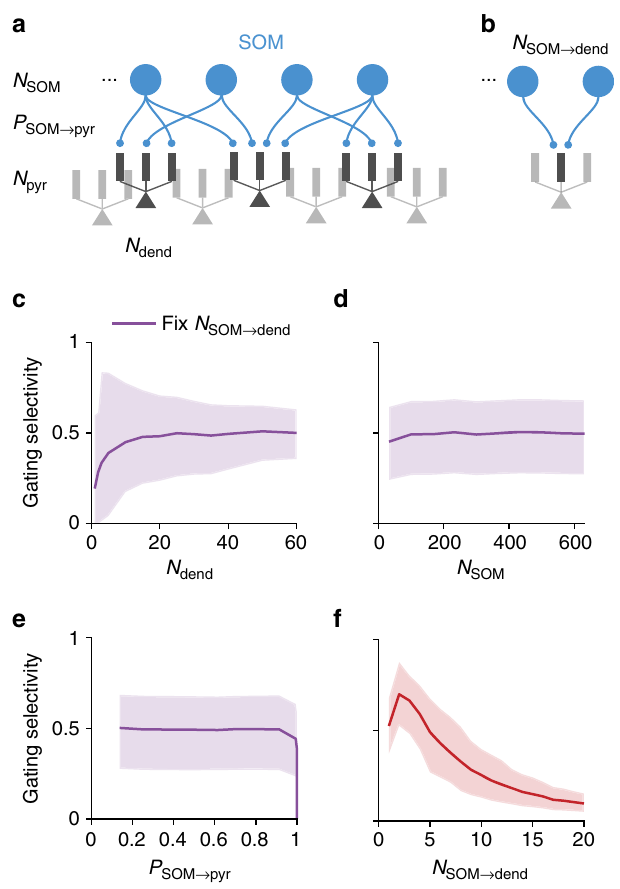
Figure 4 | Gating selectivity as functions of SOM–pyramidal circuit parameters. ( a ) A simplified model for a cortical column of SOM and pyramidal neurons. We only modelled the SOM-to-pyramidal